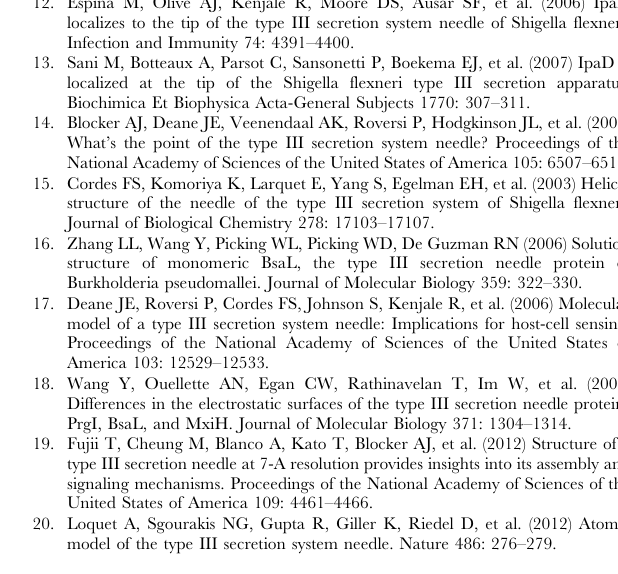
Text S1 Supporting information. Figure S1, solid-state prediction of secondary chemical shifts. Table S1, list of 2D solid- state NMR experiments. Table S2, chemical shifts of Shigella flexneri MxiH needles. Table S3, source of primary sequences for multiple sequence alignment.